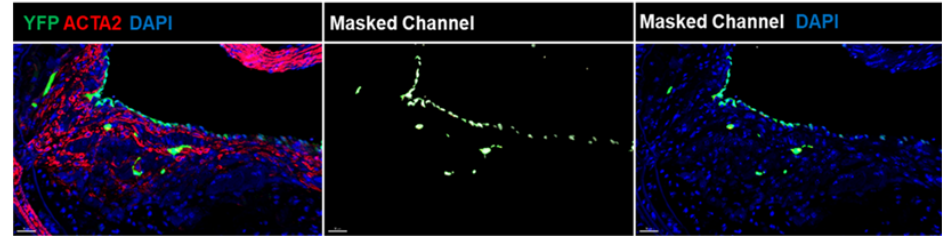
Figure 1. EndoMT in mouse atherosclerotic lesions. Immunofluorescence (IF) confocal z-stacks were analyzed using Microscopy Image Analysis Software (IMARIS) to demonstrate the unbiased co-localization for YFP and ACTA2 pixels. Ten-micrometer brachiocephalic artery cross-sections from EC-lineage tracing ( Cdh5 -CreERT2 Rosa-Stop-YFP Apoe − / − mice received 10 tamoxifen injections between 6–8 weeks of age and fed a high-fat WD for 18 weeks were stained for YFP (EC lineage tracing), ACTA2, and DAPI). Representative IF z-stacks were analyzed in IMARIS to visualize the YFP/ACTA2 pixel co ‐ localization. Based on this co ‐ localization, the masked channel was made. Next, the masked channel was applied to the DAPI channel to check for the single cell location. Scale bar = 30 μ m.